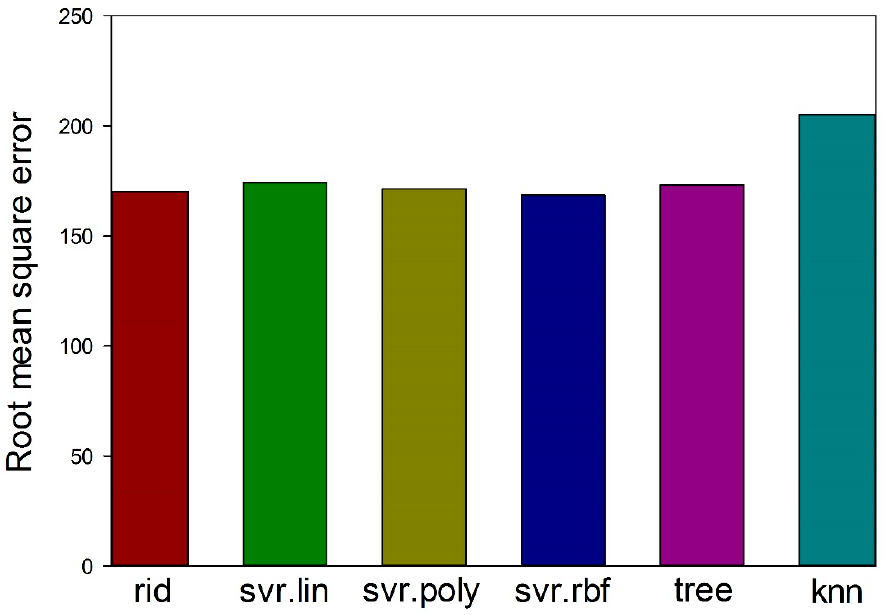
Figure 4. Ratio of root mean square errors for the models calculated using 50 bootstrap datasets.